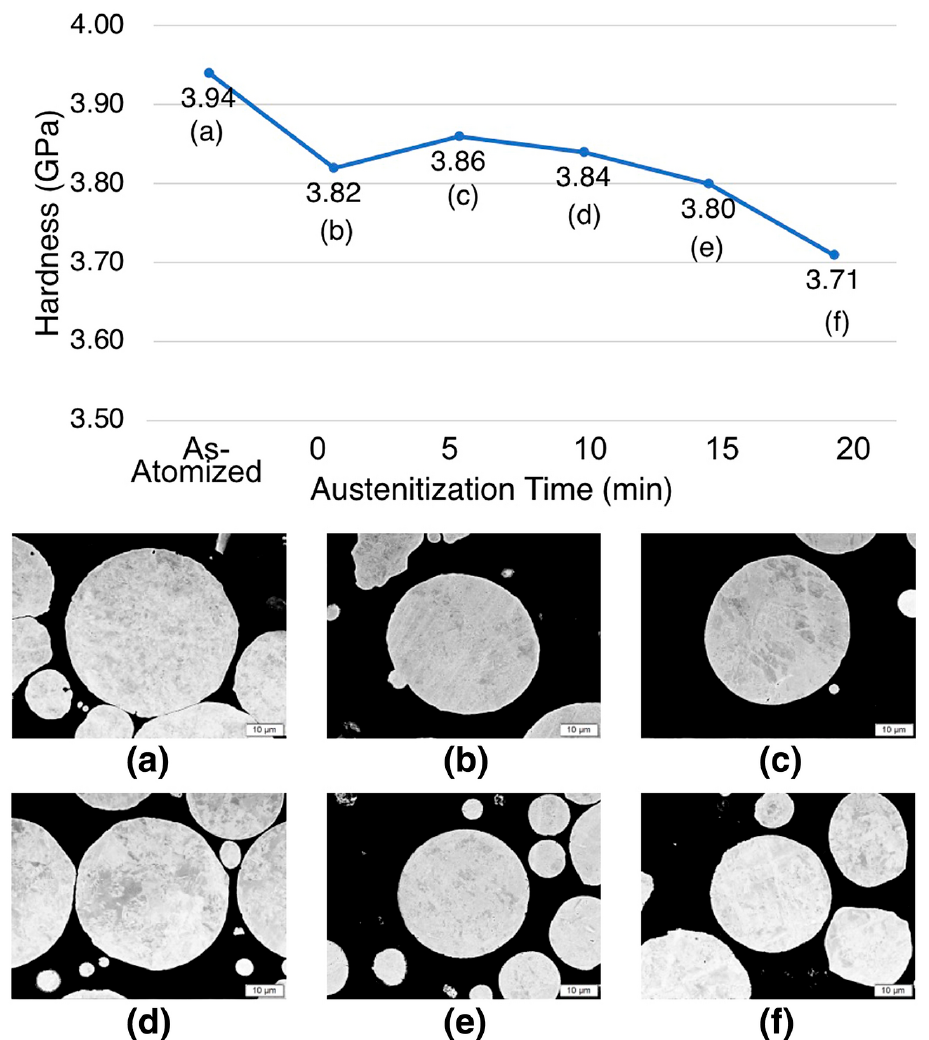
Figure 24. Hardness of the stainless-steel powder particles as a function of austenitization time are presented herein [18]. ( a – f ) present cross-sectional SEM micrographs of the powder for each austenitization time. The as-received gas-atomized powder is presented in ( a ); ( b ) depicts the powder after reaching 840 ◦ C and being immediately cooled thereafter. At the same time, ( c ) depicts the powder after reaching 840 ◦ C and being held for 5 min, while ( d ) depicts the powder after reaching 840 ◦ C and being held for 10 min. Similarly, ( e ) depicts the powder after reaching 840 ◦ C and being held for 15 min, whereas ( f ) depicts the powder after reaching 840 ◦ C and being held for 20